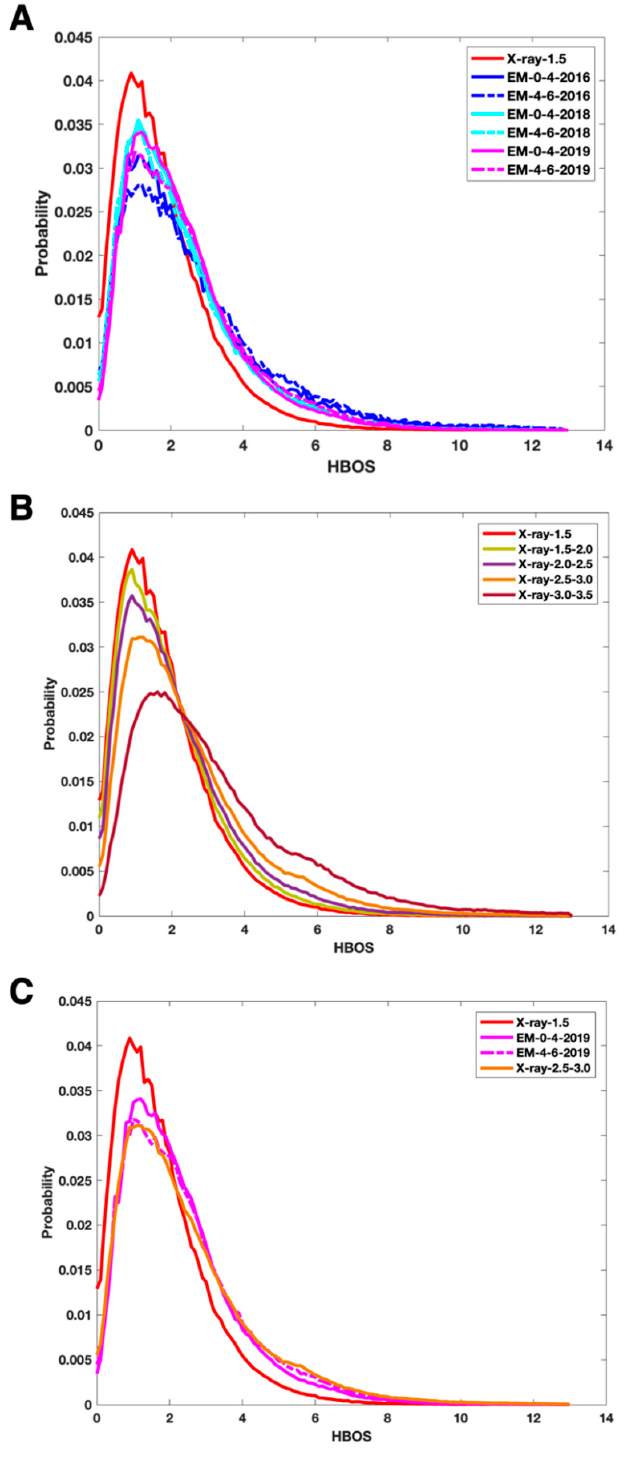
Figure 1. Probability histogram plots for seven datasets. ( A ) The probability histogram of residue HBOS scores in X-ray-1.5 (red solid), EM-0-4-2016 (blue solid), EM-4-6-2016 (blue dash line), EM-0-4-2018 (cyan solid), EM-4-6-2018 (cyan dash line), EM-0-4-2019 (magenta solid), and EM-4-6-2019 (magenta dash line). ( B ) The probability histogram of residue HBOS scores in X-ray-1.5 (red solid), X-ray-1.5–2.0 (olive solid), X-ray-2.0–2.5 (purple solid), X-ray-2.5–3.0 (orange solid), and X-ray-3.0–3.5 (maroon solid). For clear viewing, four curves are shown for X-ray-1.5, EM-0-4-2019, EM-4-6-2019, and X-ray-2.5–3.0 in ( C ).